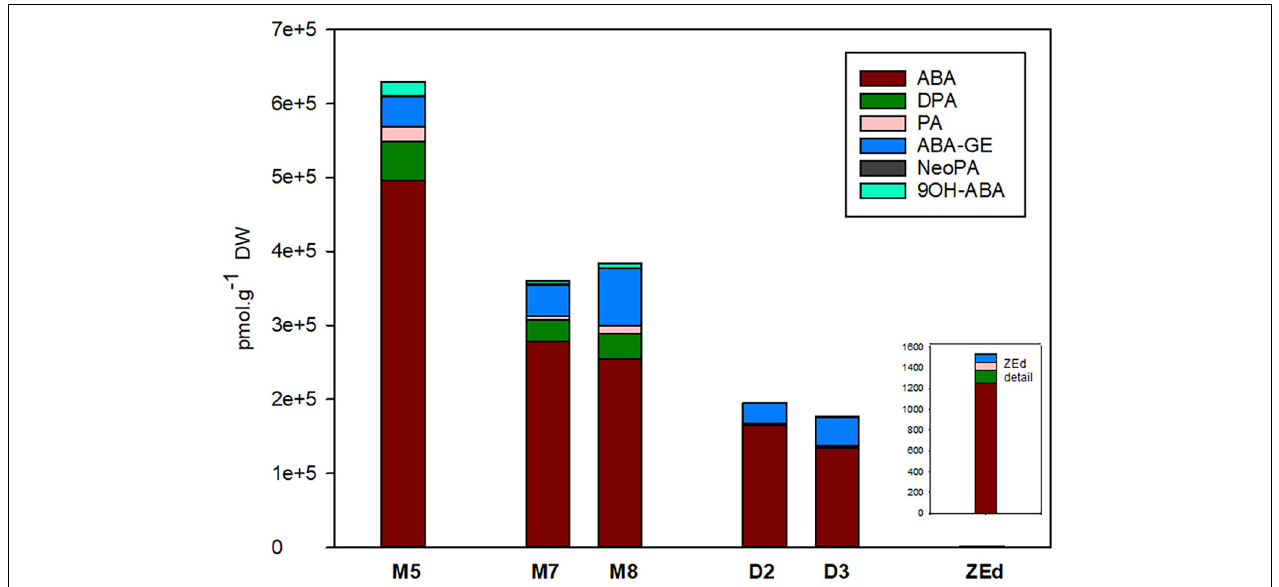
FIGURE 6 | Content of ABA and its derivatives in P. abies somatic (SEs) and zygotic (ZEs) embryos. M5 – mature SEs after 5 weeks of maturation, M7 and M8 – SEs after 7 and 8 weeks of prolonged maturation, D2 and D3 – SEs after 2 and 3 weeks of desiccation, ZEd – dry ZEs. ABA, abscisic acid; ABA-GE, ABA-glucosylester; PA, phaseic acid; DPA, dihydrophaseic acid; NeoPA, neophaseic acid; 9OH-ABA, 9-hydroxy-ABA.